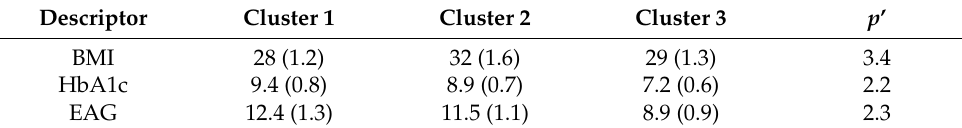
Table 2. Variables of the best k-means clustering for arterial hypertonia underlying disease.